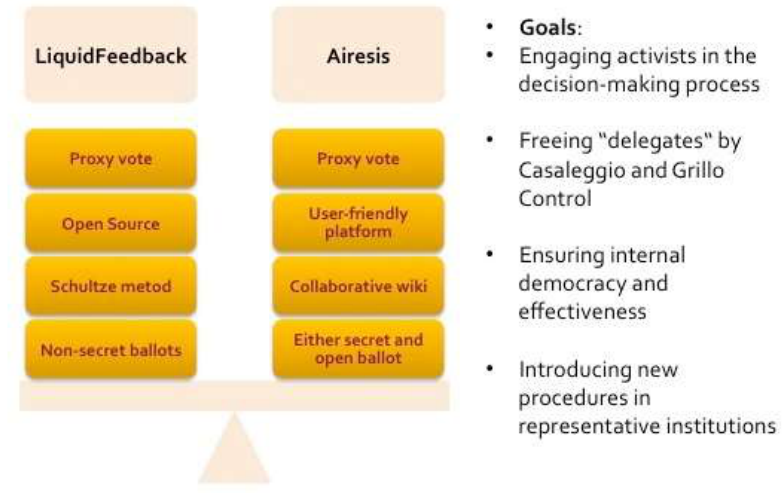
Figure 5: Liquid Democracy